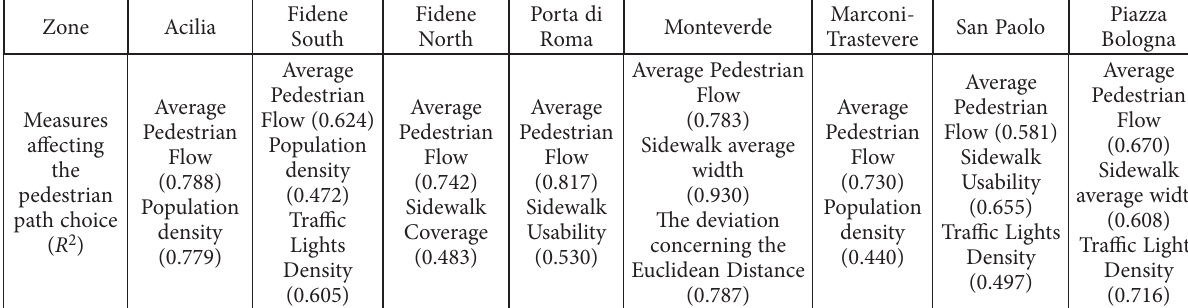
Table 4. Walkability measures for several zones in Rome (Gori, Nigro, & Petrelli,